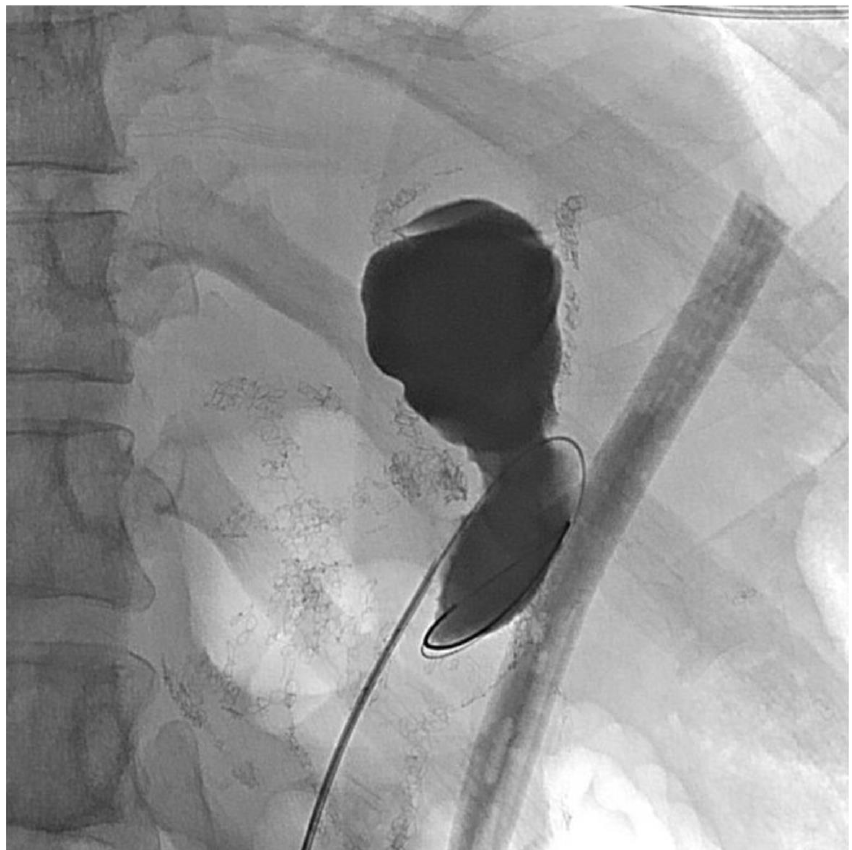
Figure 10. Wire across into orphaned stomach segment (fluoroscopic view).